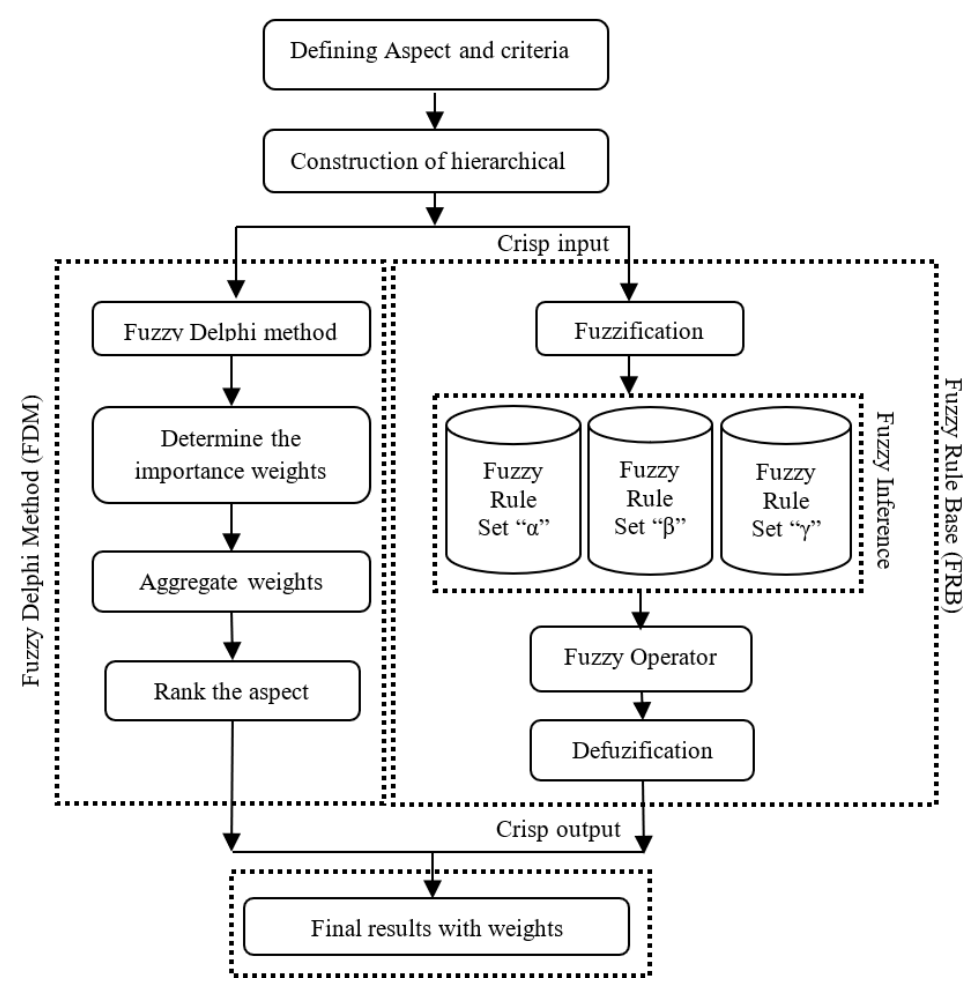
Figure 3. Process flow of fuzzy decision-making system (FDMS) structure.